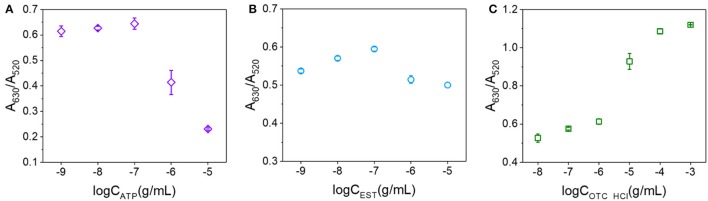
Relationships between the A630/A520 ratios and analyte concentrations. (A) For ATP concentrations ranging from 10−9 to 10−5 g/mL. (B) For EST concentrations ranging from 10−9 to 10−5 g/mL. (C) For OTC·HCl concentrations ranging from 10−8 to 10−3 g/mL.